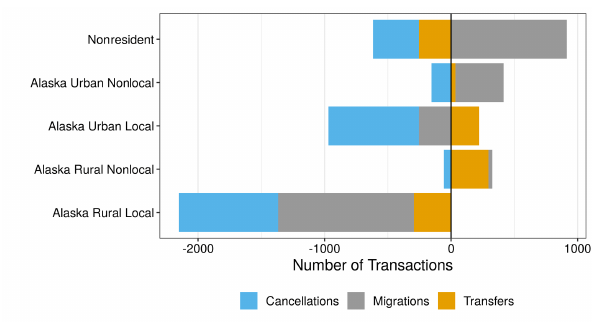
Fig. 1 . Net change in permit holdings by residency category,